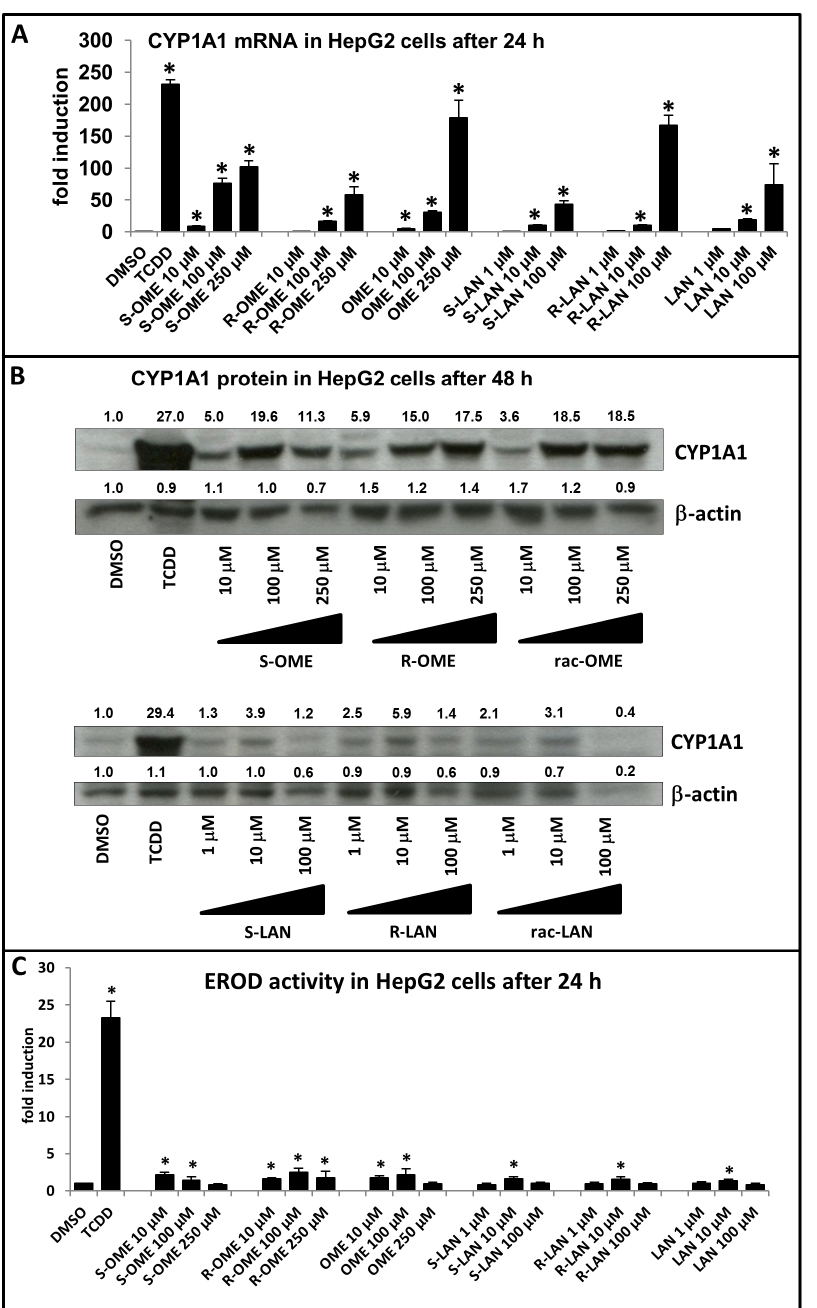
Figure 2. Effects of omeprazole and lansoprazole enantiomers on CYP1A1 mRNA, protein and catalytic activity in human cancer cell line HepG2. HepG2 cells were seeded in 6-well plates and stabilized for 16 h. All experiments were performed in three consecutive cell passages. Cells were incubated for 24 h (mRNA and EROD analysis) or 48 h (protein analysis) with TCDD (5 nM), vehicle (DMSO; 0.1% v/v), omeprazole (S-, R-, rac-; 10 m M, 100 m M, 250 m M) and lansoprazole (S-, R-, rac-; 1 m M, 10 m M, 100 m M). Panel A: Representative RT-PCR analyses of CYP1A1 mRNA are shown. The data are the mean 6 SD from triplicate measurements and are expressed as a fold induction over vehicle-treated cells. The data were normalized to GAPDH mRNA levels. Panel B: Representative western blots of CYP1A1 protein are shown. Density of bands was quantified by densitometry and the values are indicated along with respective blots. Panel C: CYP1A1 catalytic activity (7-ethoxyresorufin- O -deethylase; EROD) was measured by spectrofluorometry with 530 nm excitation and 590 nm emission filters. Treatments were performed in triplicates. Average EROD data from three independent passages are showed. Data are expressed as a fold induction over vehicle-treated cells. An asterisk (*) indicates that the value is significantly different from the activity of vehicle-treated cells.